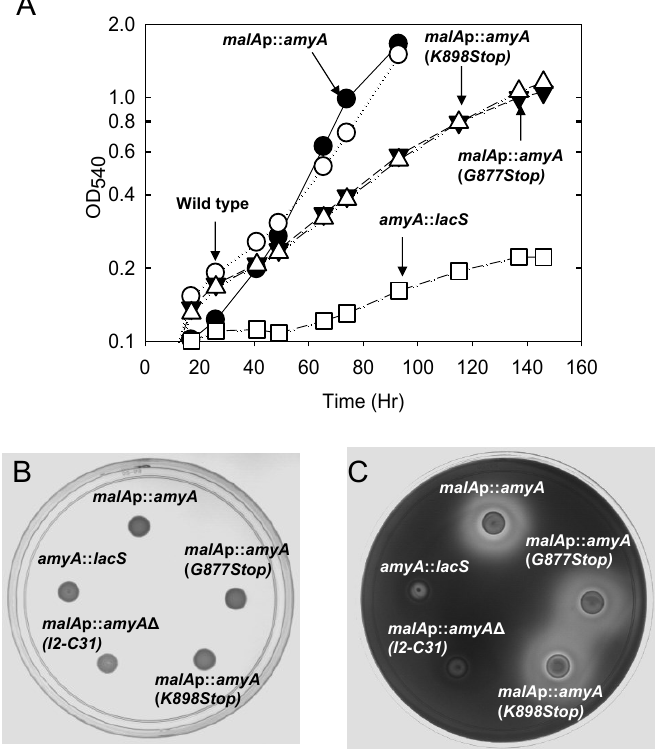
Figure 5. Panel A , Efficiency of starch utilization during growth in liquid culture. Strains were grown at 80 °C in batch culture with aeration using a minimal starch medium. Strains were; Gly877Stop mutant (PBL2059, closed triangles), Lys898Stop mutant (PBL2065, open triangles), wild type (PBL2025; open circles), malAp :: amyA promoter fusion (PBL2058, closed circles) and amyA :: lacS disruption (PBL2004, open squares). Amy A production during growth on a solid medium. Panel B , no treatment. Panel C , Iodine treatment. Numbered spots were: 1 ( malA p- amyA , PBL2058), 2 (Gly877Stop mutant PBL2059), 3 (Lys898Stop mutant, PBL2065), 4 ( N -terminal deletion mutant, PBL2064), 5 ( amyA :: lacS disruption mutant, PBL2004). All spots contained 10 7 cells and plates were incubated at 80°C for 6